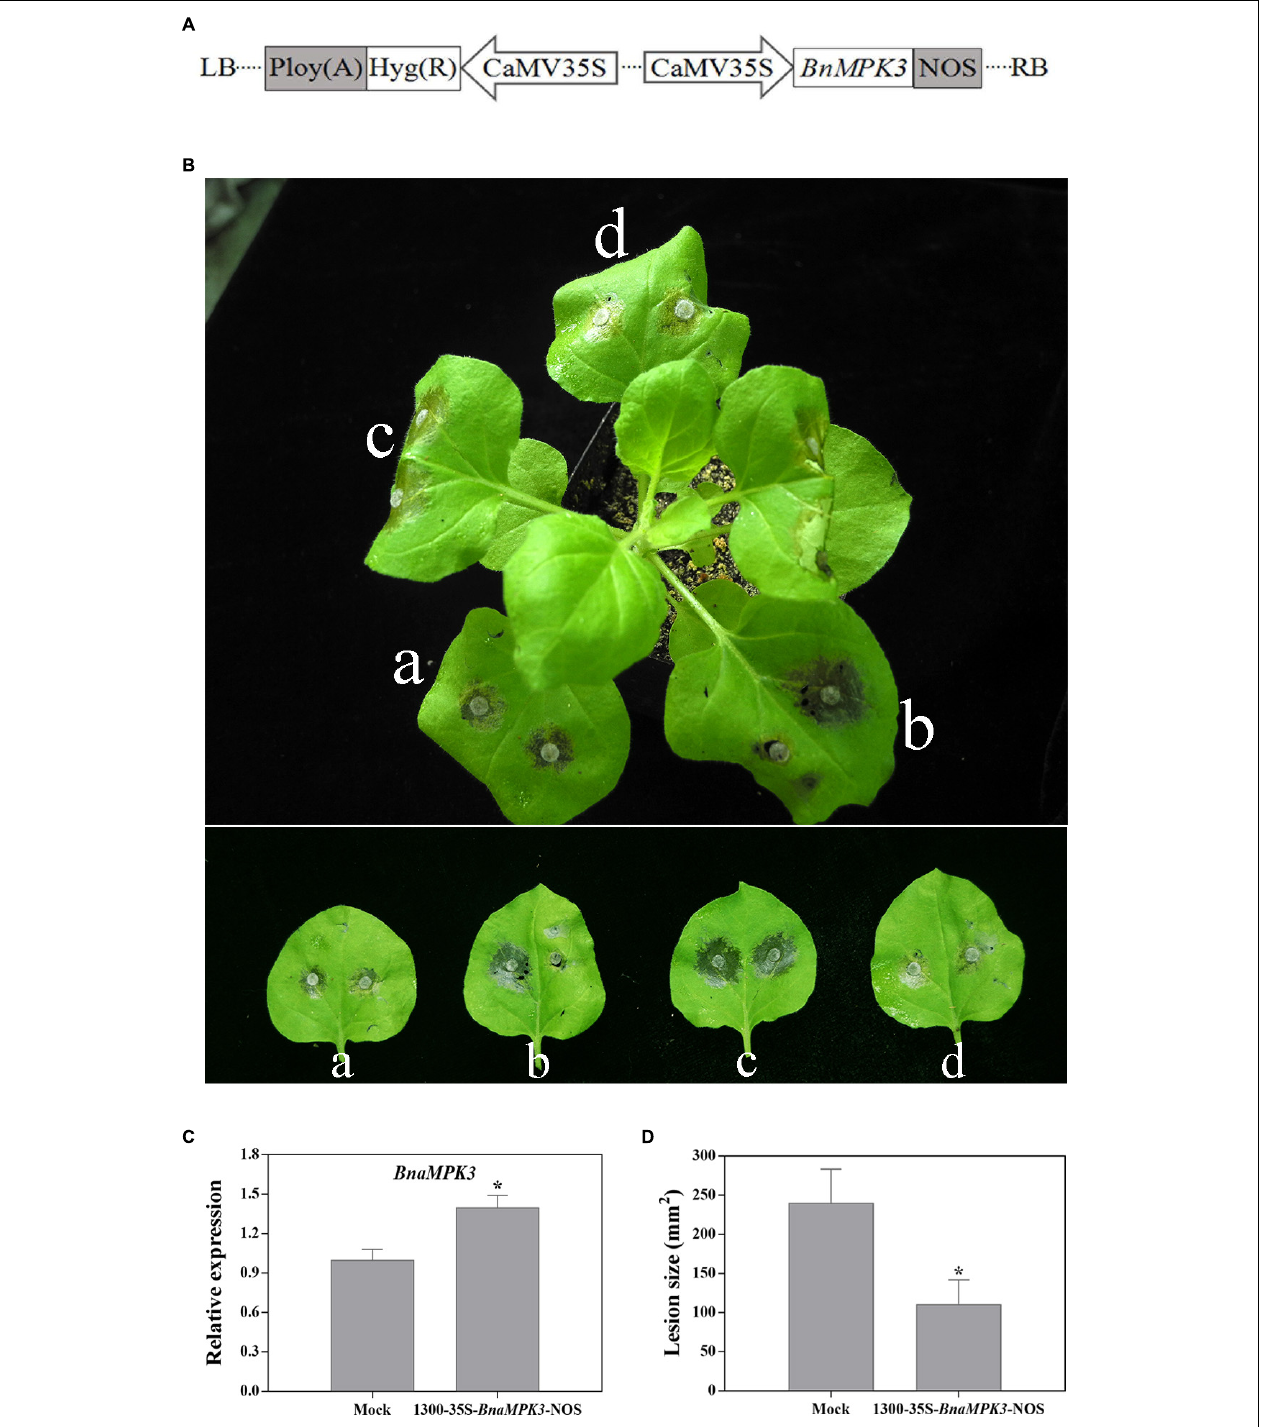
FIGURE 3 | Nicotiana benthamiana transiently expressing BnaMPK3 enhances resistance to S. sclerotiorum . (A) Diagram of the plasmids of 1300-35S- BnaMPK3 -Nos used in this analysis. CaMV35S, cauliflower mosaic virus 35S promoter; NOS, terminator. (B) Expression of BnaMPK3 in N. benthamiana enhanced resistance to S. sclerotiorum . (a) Both left and right panel of the leaves were treated with 1300-35S- BnaMPK3 -Nos vector solution. (b) The left panel of a leaves was treated with mock solution, and the right panel of the leaf was treated with 1300-35S- BnaMPK3 -Nos vector solution. (c) Both left and right panel of the leaves were treated with mock solution. (d) Both left and right panel of the leaves were treated with 1300-35S- BnaMPK3 -Nos vector solution. (C) Relative expression of BnaMPK3 in the treatment with mock or 1300-35S- BnaMPK3 -Nos vector. (D) Lesion diameters were measured 36 h post-inoculation. Means and standard errors are shown. Letters indicate statistically significant differences ( P < 0.05). The experiment was repeated three times with similar results.